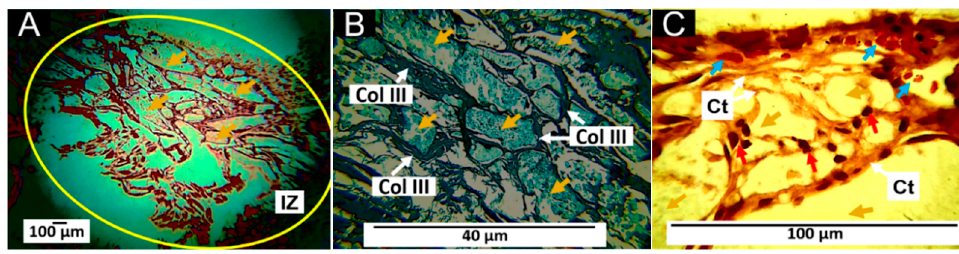
Figure 12. Subdermal implantations of F2 (22%PCL/70%PLA/5%Gly/3%ZnO-NPs) at 60 days. ( A ): Formulation F2 at 4× HE technique. ( B ): Formulation F2 at 40× GT technique. ( C ): Formulation F2 at 100× HE technique. Yellow oval: Implantation area. Col III: type III collagen. Ct: connective tissue. IZ: Implantation zone. Yellow arrows: Fragments of the F2 material. Red arrows: inflammatory cells. Blue arrows: blood vessels. HE: Hematoxylin and Eosin technique. GT: Gomori Technique.